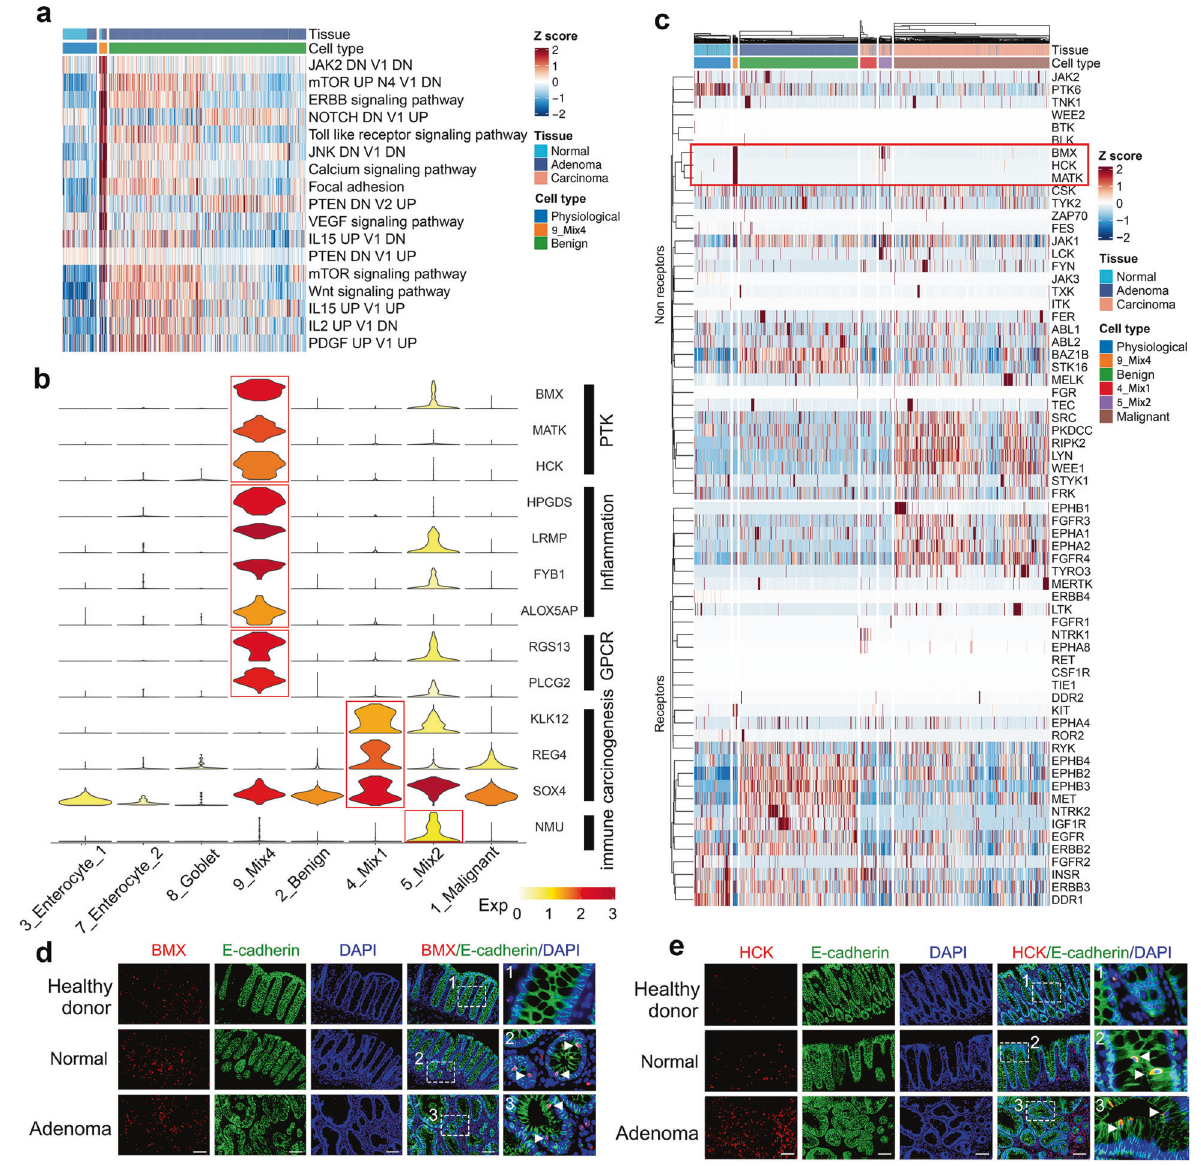
version 2. b Violin plot showing log-normalized expression levels of subset-speci fi c genes in physiological (cluster 3, 7, and 8), benign, malignant, and intermediate populations (cluster 4, 5, and 9). Colors represent average expression levels within a cluster. c Hierarchically clustered heatmap showing the log-normalized expression levels of all expressed RTK/PTK genes in P1 epithelial cells. Columns represent cells annotated with cell type and tissue. Colors represent Z scores. d , e Co-immuno fl uorescence staining of E-cadherin with BMX ( d ) or HCK ( e ) was conducted for healthy donor colonic, CRC patient normal, and adenoma tissues. White arrows indicate positively stained epithelial cells. Scale bar, 100 μ